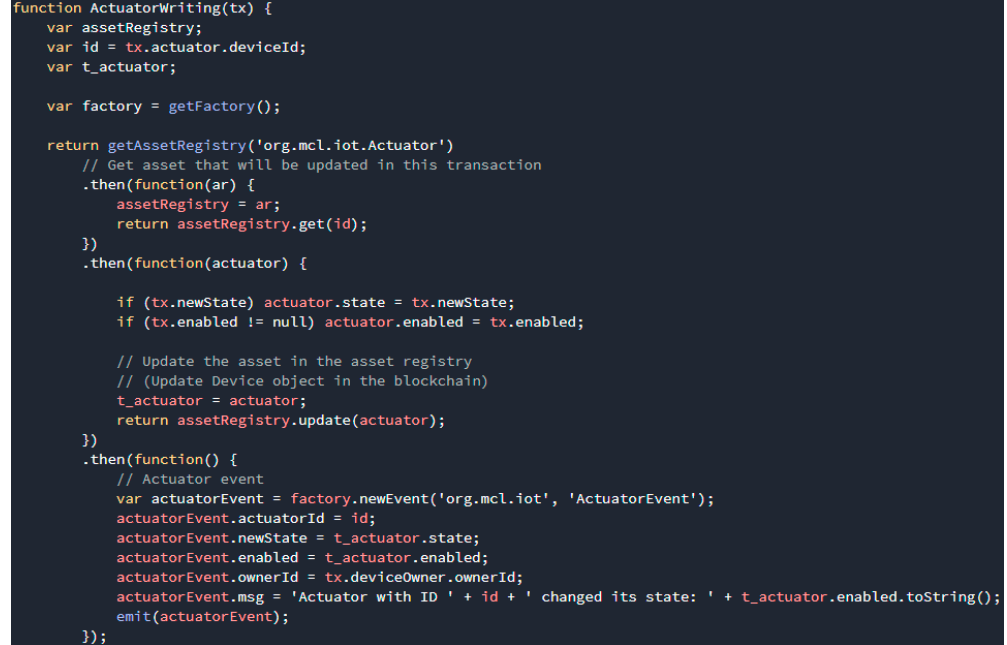
Figure 9 . Transaction processor function for actuator writing transaction. Figure 9. Transaction processor function for actuator writing